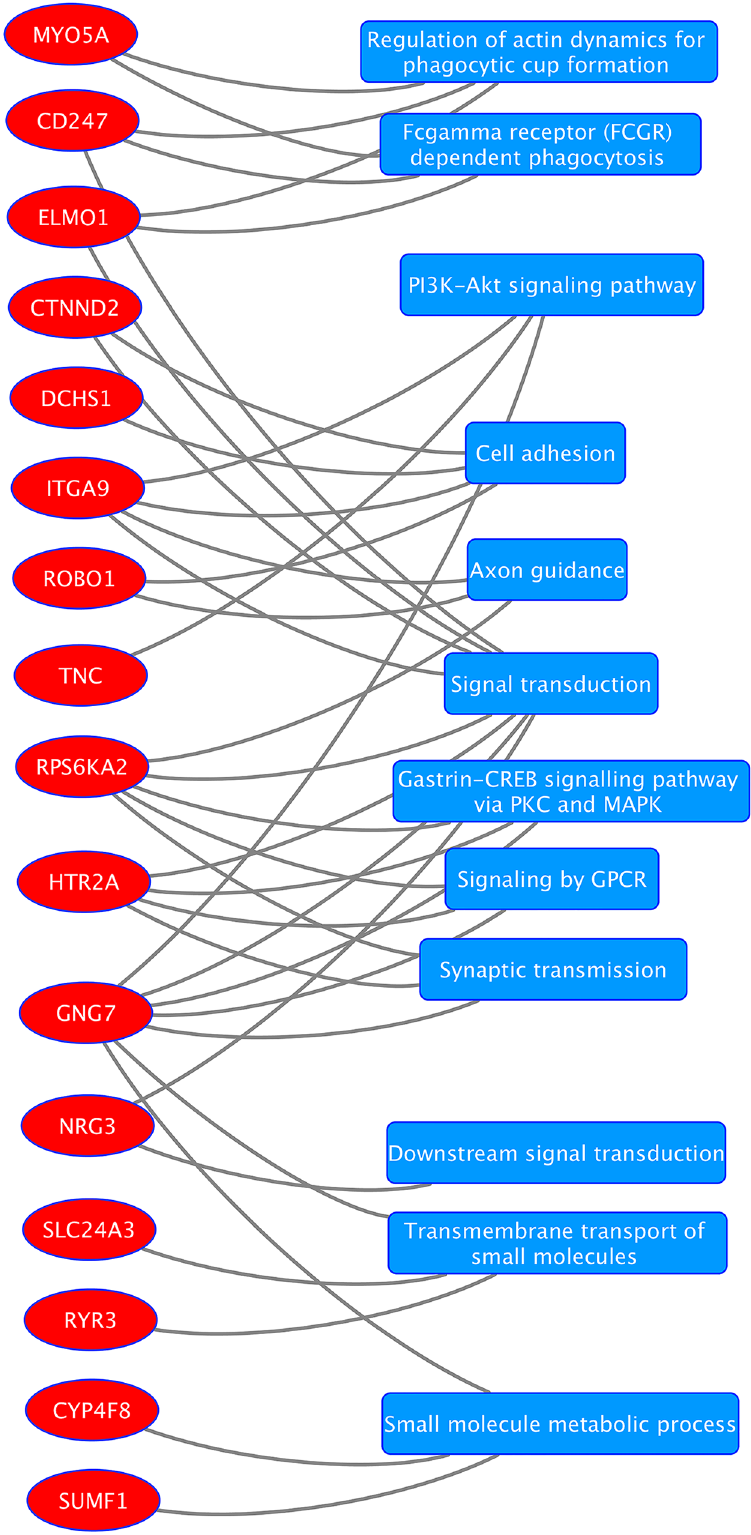
Fig 6. Hierarchal plot showing 16 genes in red circles and 11 pathways in blue rectangles. Connection between the genes and pathways was established using Biofilter